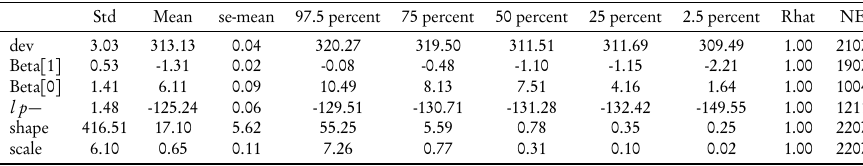
Bayesian performance results of breast cancer with rstan function for MO-G